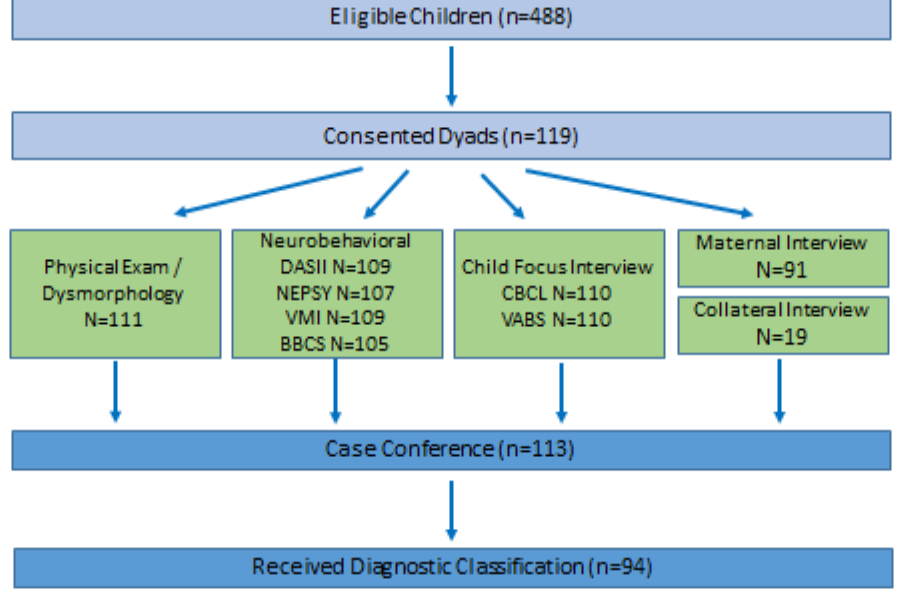
Figure 1. Study Figure 1. Study Flowchart. Table 1. Characterization of Sample.